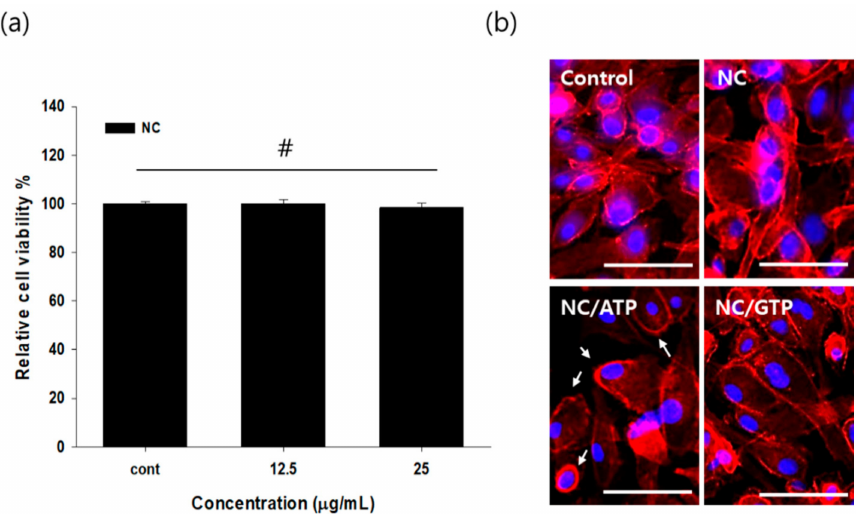
Figure 2. Biocompatibility of NC and rearrangement of the cytoskeleton of ARPE-19 after treatment with NC–ATP. ( a ) Metabolic activity of ARPE-19 measured by a Cell Counting Kit-8 (CCK) assay after 24 h of treatment with NC. #: No significant difference by t -test with p > 0.05. ( b ) Representative images of F-actin staining of ARPE-19 with phalloidin Alexa-594 (red). Blue: Nuclear staining with DAPI. The observed round cell morphology is indicated by arrows (scale bar: 100 µ